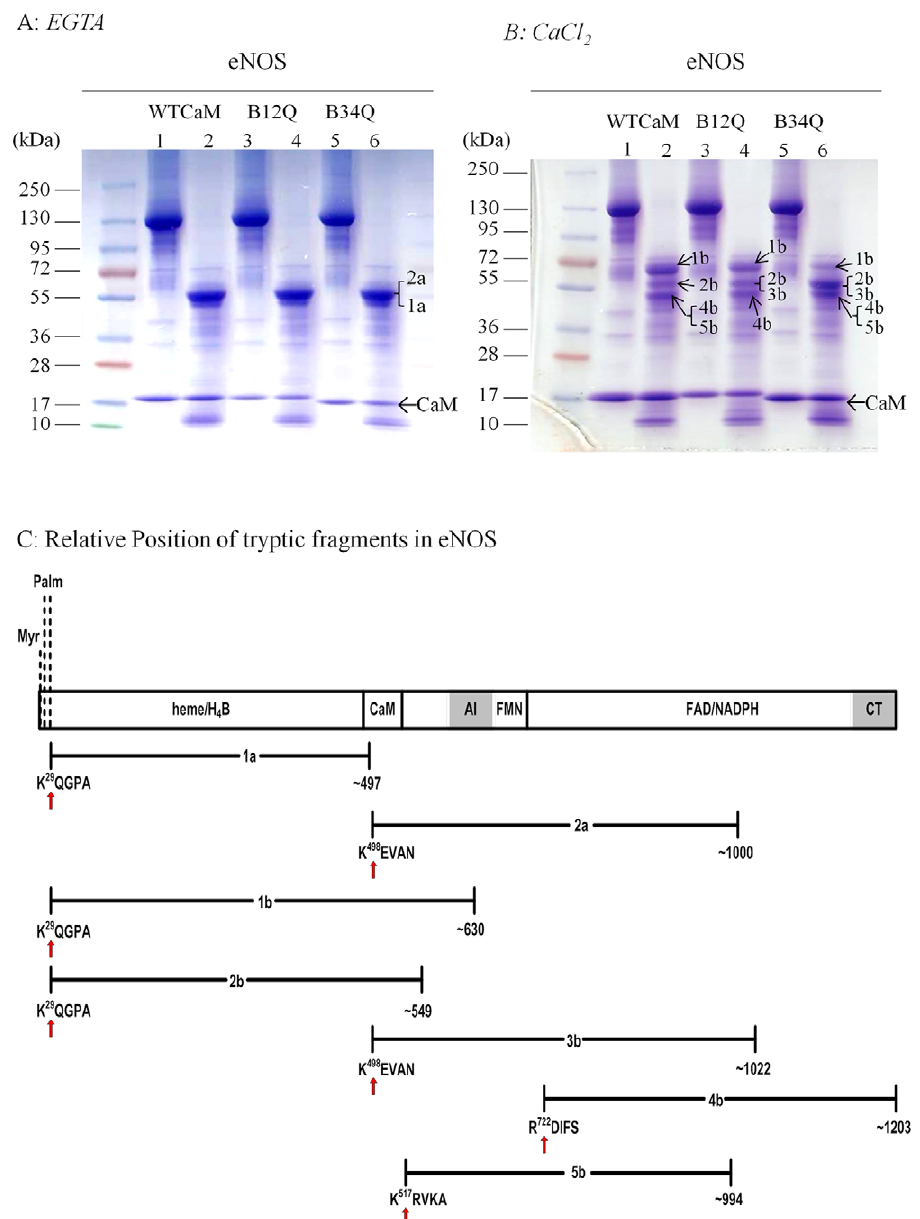
Figure 6. Limited trypsinolysis of eNOS in the presence of wild-type CaM, B 12Q or B 34Q . A: Trypsinolysis of eNOS ( , 5 m M) was performed in the presence of 10 m M of wild-type CaM, B 12Q or B 34Q at 22 u C for 15 min with 1 mM EGTA. B: Trypsinolysis was carried out in the presence of 100 m M CaCl 2 . Lane 1: undigested eNOS with wild-type CaM; lane 2: trypsinized eNOS with wild-type CaM; lane 3: undigested eNOS with B 12Q ; lane 4: trypsinized eNOS with B 12Q ; lane 5: undigested eNOS with B 34Q ; lane 6: trypsinized eNOS with B 34Q . Molecular masses of marker proteins are shown on the left in kilodaltons (kDa). Following SDS-PAGE, the tryptic samples were transferred to PVDF membranes using CAPS buffer for 3 h at 50 V and 4 u C. The bands excised for N-terminal sequencing are indicated. C: Relative position of N-terminal sequences of the indicated tryptic fragments in the schematic eNOS structure. The C-terminal termination sites are unknown and the residue at C-terminal end in each tryptic fragment was approximately estimated from the apparent molecular mass. Red arrow depicts the tryptic cleavage site. The blocks indicate binding sites for heme, H 4 B, CaM, FMN, FAD and NADPH. AI and CT refer to autoinhibitory loop and C-terminal tail, respectively. The myristoylation site (Myr.) and palmitoylation sites (Palm.) are denoted.